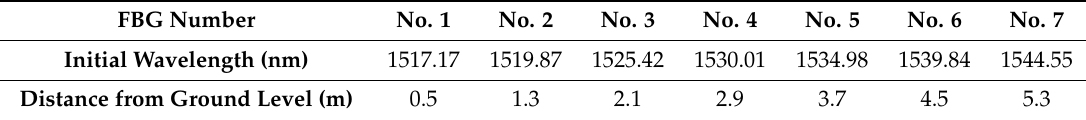
Table 1. Details of the fiber Bragg grating (FBG) sensors used.